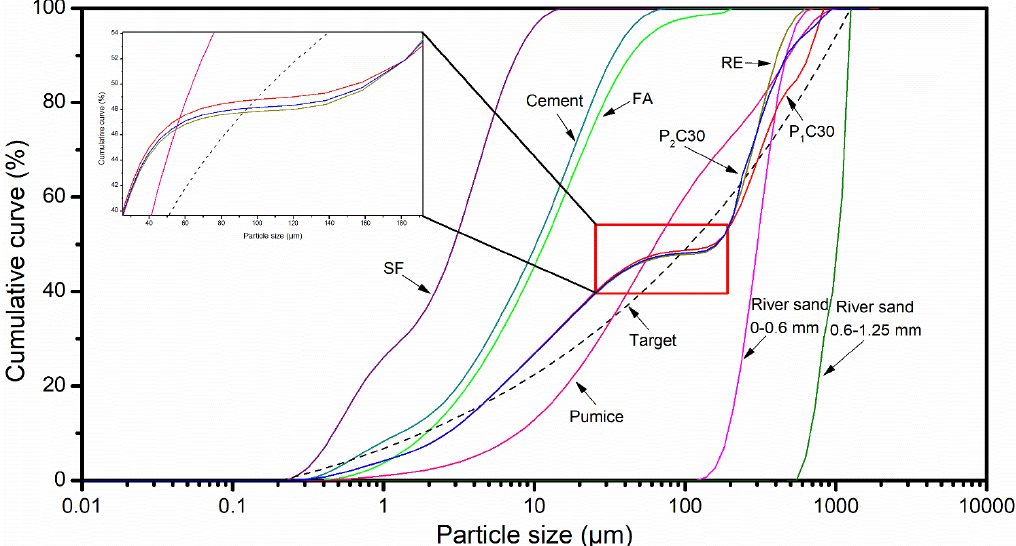
Figure 3. Particle size distributions (PSDs) of the crude materials, the target, and optimized grading curves of the composites on account of optimized pre-wetting pumice substances.